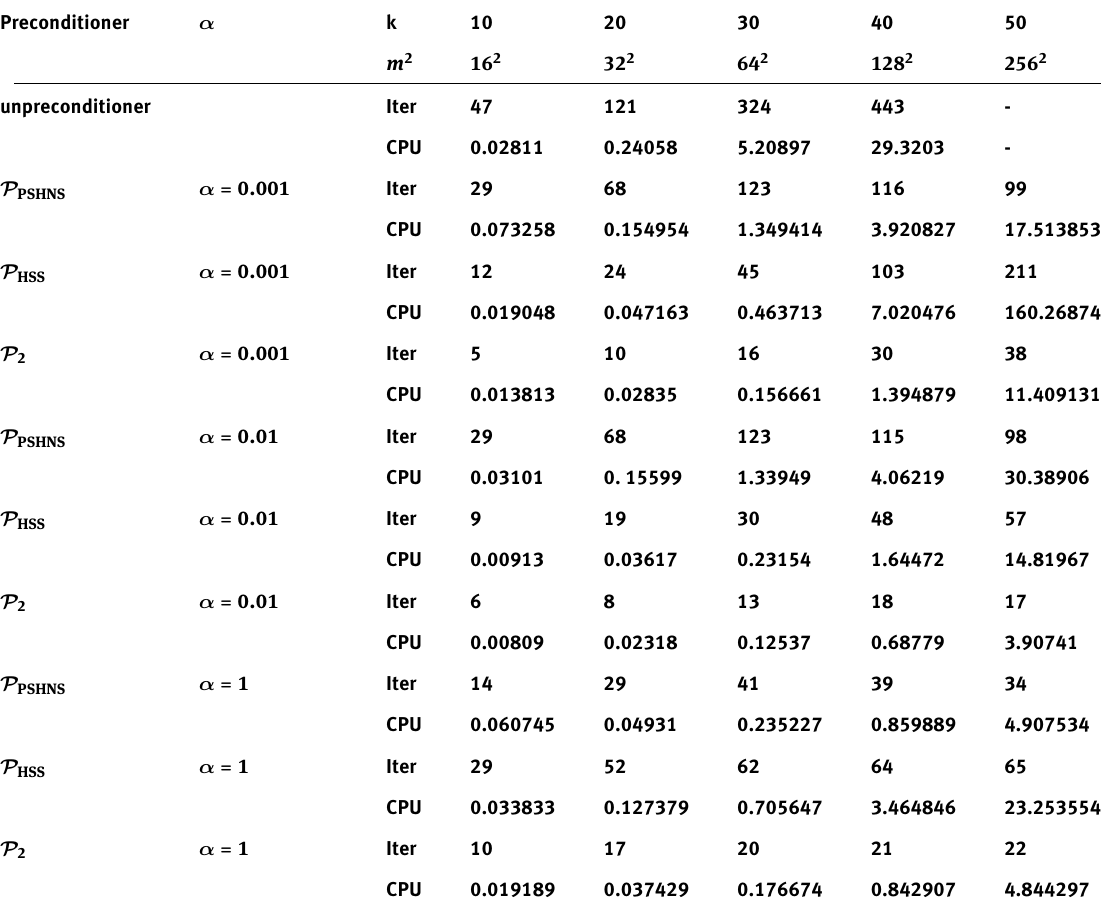
Table 2. Numerical results of GMRES and Preconditioned GMRES methods for Example